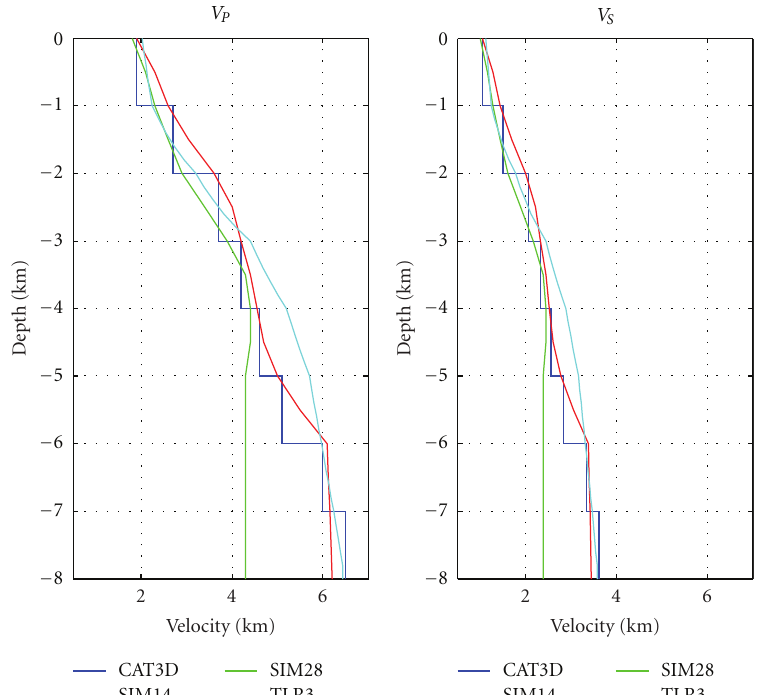
Figure 13: Initial 1D velocity models for V P and V S velocities. The V P /V S was set constant and equal to 1.8 throughout the whole model by all